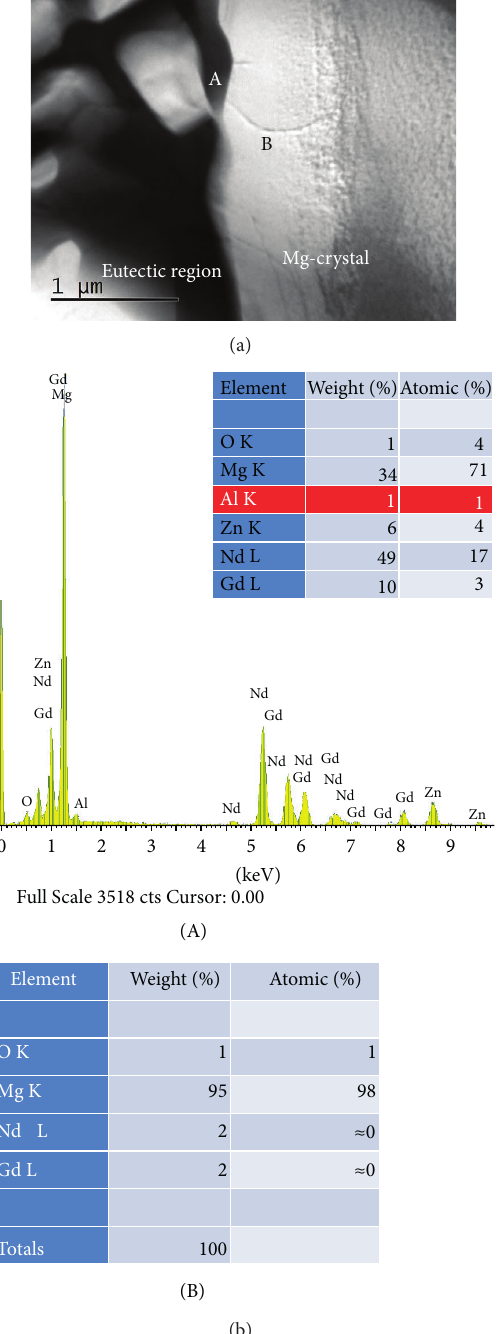
with magnesium to form MgO, as confirmed by the direct TEM observation of MgO particles, as shown in Figure